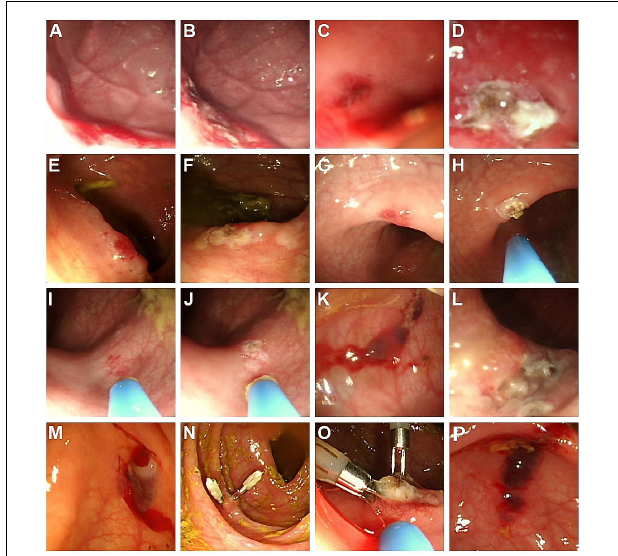
FIGURE 1 | Endoscopic findings of AD in the five cases. (A) Case 1: Angiodysplastic lesions at the greater-curvature side of high body and